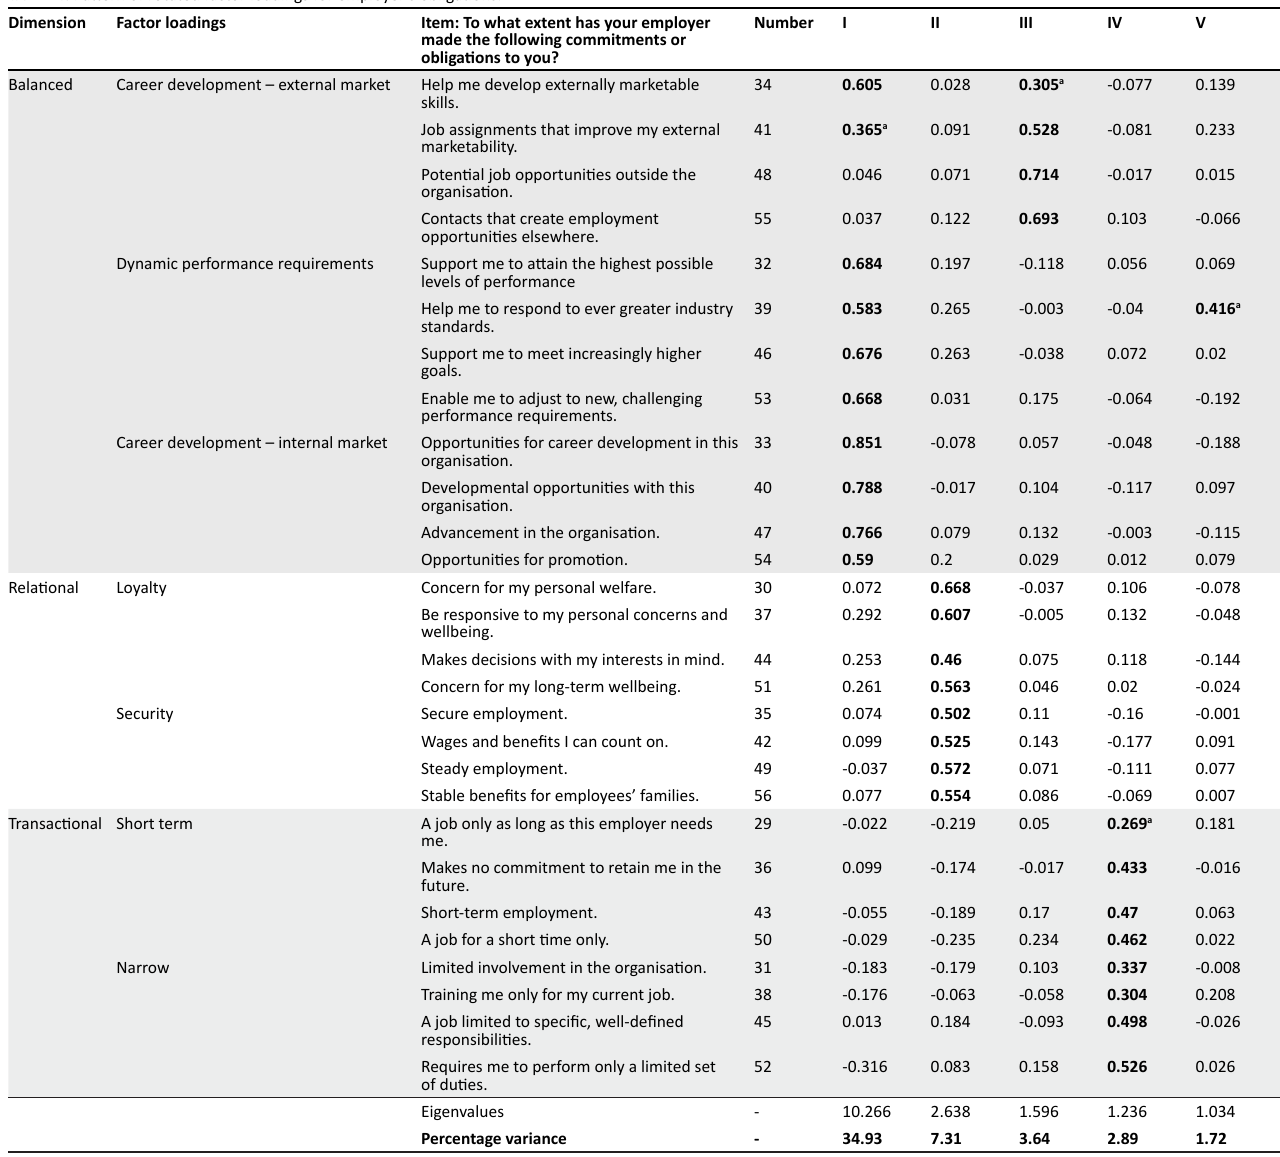
TABLE 4: Pattern of rotated factor loadings for employer’s obligations. Dimension Factor